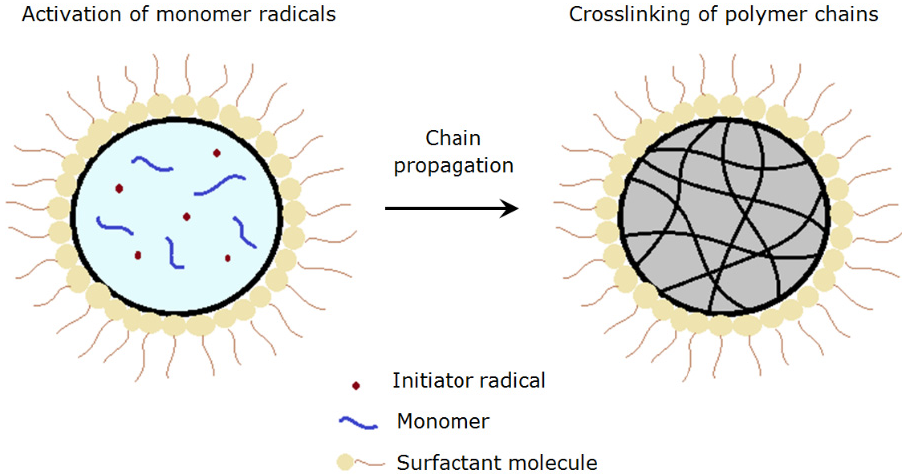
Figure 4. Schematic depiction of polyNIPAm particle formation, via suspension